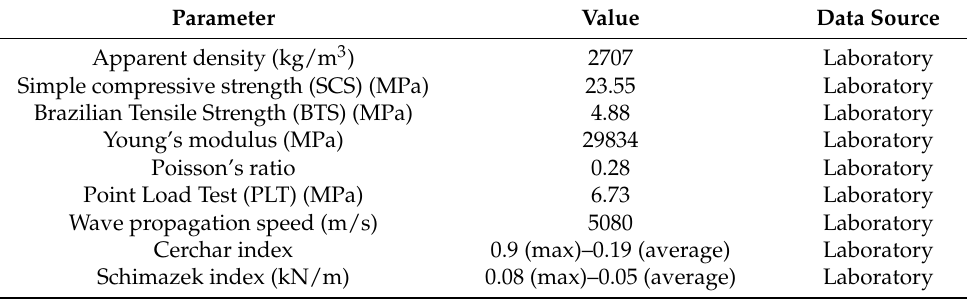
Table 2. Average geotechnical parameters of the 4B formation.